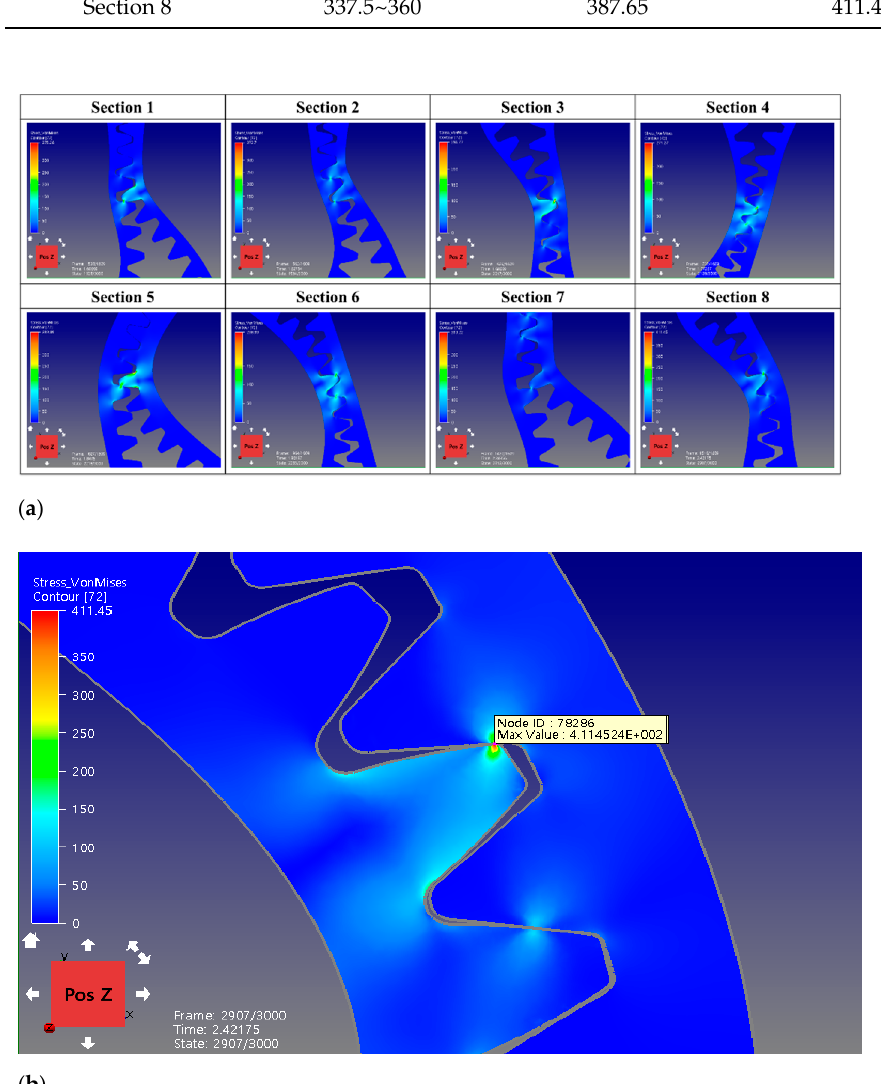
Figure 19. The simulation results of structural evaluation of non-circular gears. ( a ) The maximum Von-Mises stress in each section. ( b ) The maximum Von-Mises stress at the Section (8)